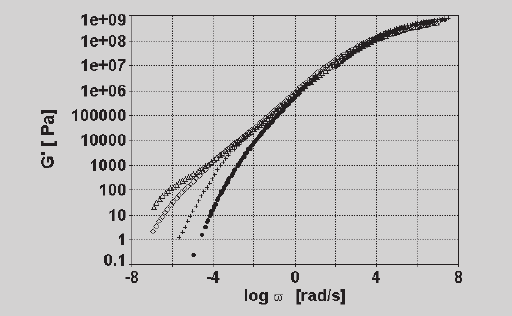
Figure 3: Storage